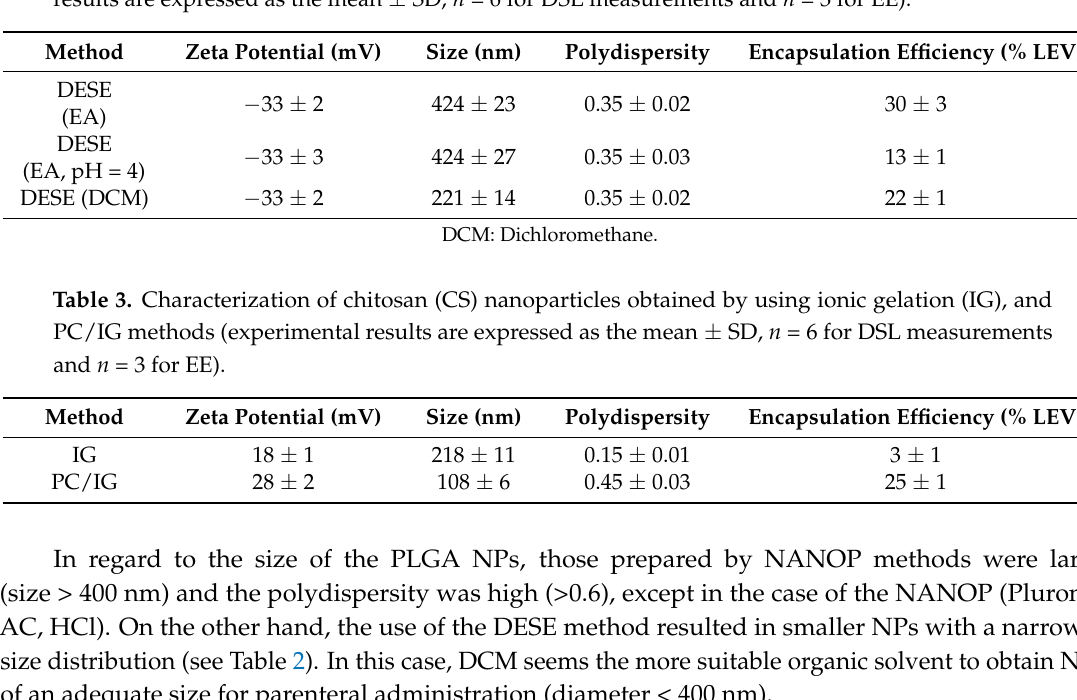
Table 2. Characterization of PLGA nanoparticles obtained by using DESE methods (experimental results are expressed as the mean ± SD, n = 6 for DSL measurements and n = 3 for EE).